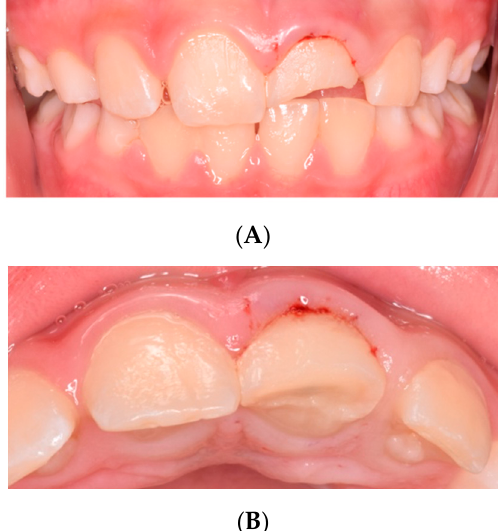
Figure 1. Intra-oral frontal photography. ( A ) Preoperative buccal clinical view of the anterior teeth. ( B ) Preoperative incisal clinical view of the anterior teeth.